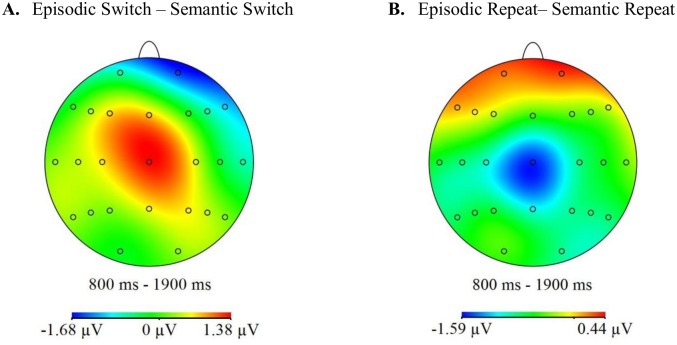
Topographic maps calculated using a spherical spline interpolation.The maps were computed from difference scores obtained by subtracting mean amplitudes associated with semantic cues from those associated with the episodic cues on switch (A) and repeat (B) trials for the 800 to 1900ms time window. The scale below each map denotes the voltage range (μV) of the differences between cue-elicited activities.